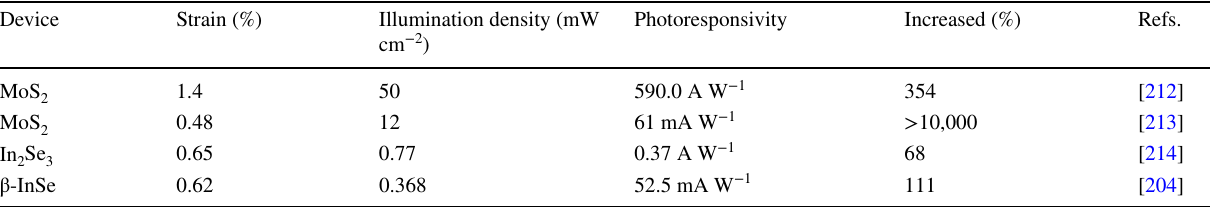
Table 4 A list of piezoresistivity-enhanced performance of the photodetectors constructed by 2D semiconductors